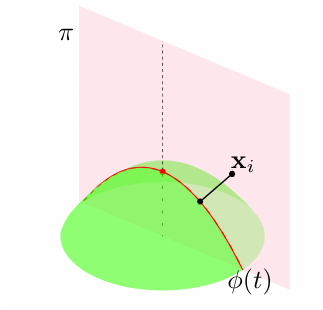
Figure 4. The distance between a point and a paraboloid is re- duced to computing the distance between a point and a parabola in the